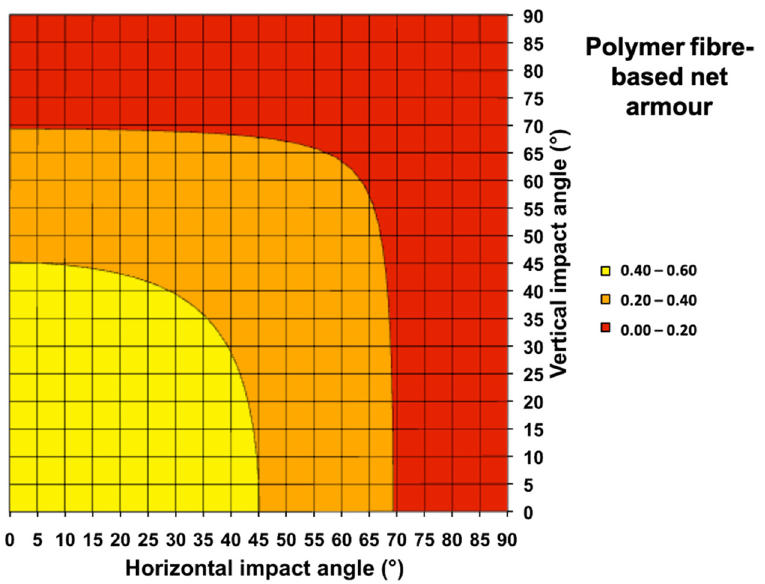
Figure 22. Efficiency of a polymer fibre-based net cage armour solution as a function of the horizontal and vertical impact angle.